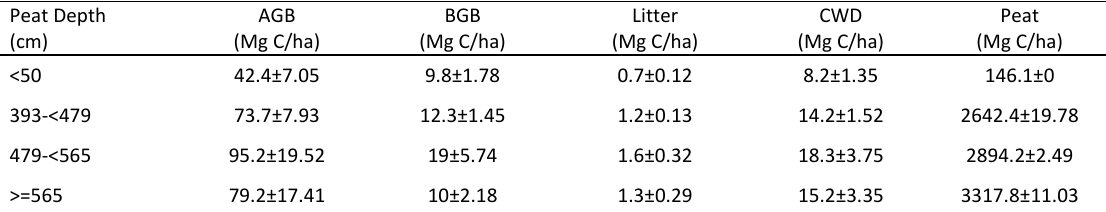
Table 7: Carbon stock (Mg C/ha) in each carbon pool at different peat depths.